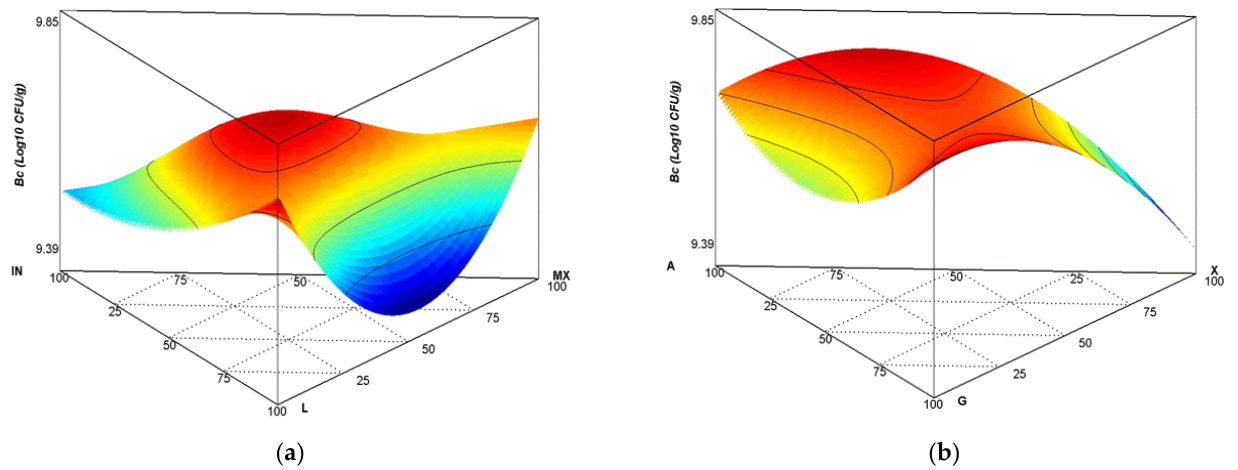
Figure 2. Graphics of surface responses to viability of B. clausii dried by lyophilisation, expressed as log10 (CFU/g). ( a ) Matrix I, IN:L:MX; ( b ) matrix II, A:G:X.